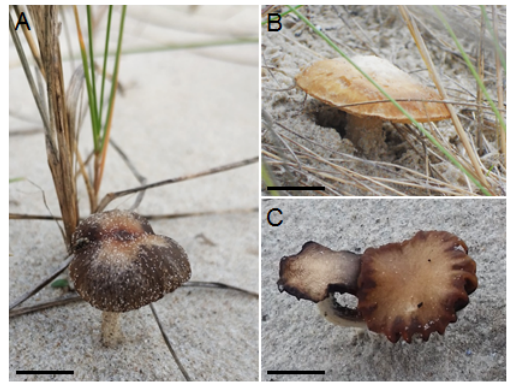
Figure 1 Basidiocarps of Psathyrella ammophila from the Wolin Island (August 14, 2012; October 26, 2019). Scale: 1 cm. Photographs by K. Mazurkiewicz-Zapałowicz ( B ) and M. Stasińska ( A,C ).